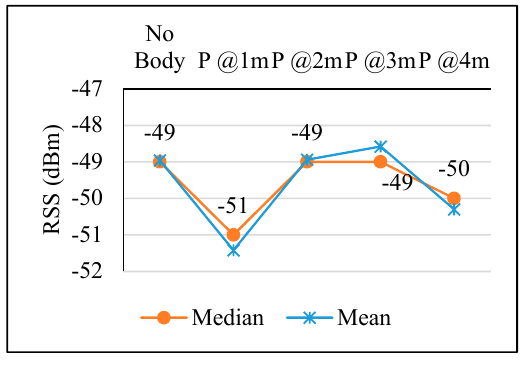
Figure 21. PPE in VLOS case 1.